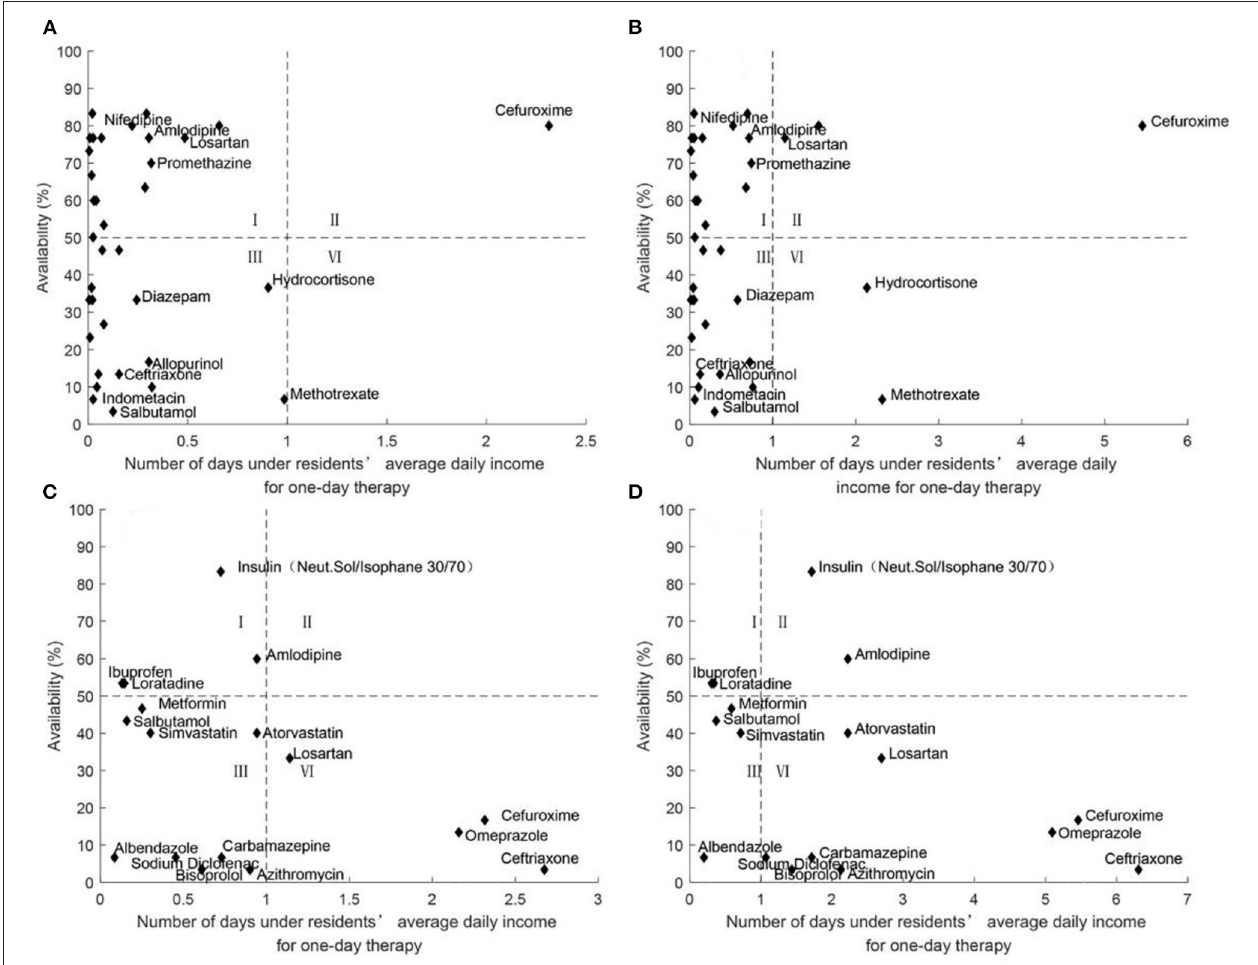
FIGURE 3 | Comprehensive analysis of medicine availability and affordability in 2017. (A) Comprehensive analysis of LPGs availability and affordability for urban residents. (B) Comprehensive analysis of LPGs availability and affordability for rural residents. (C) Comprehensive analysis of OBs availability and affordability for urban residents. (D) Comprehensive analysis of OBs availability and affordability for rural